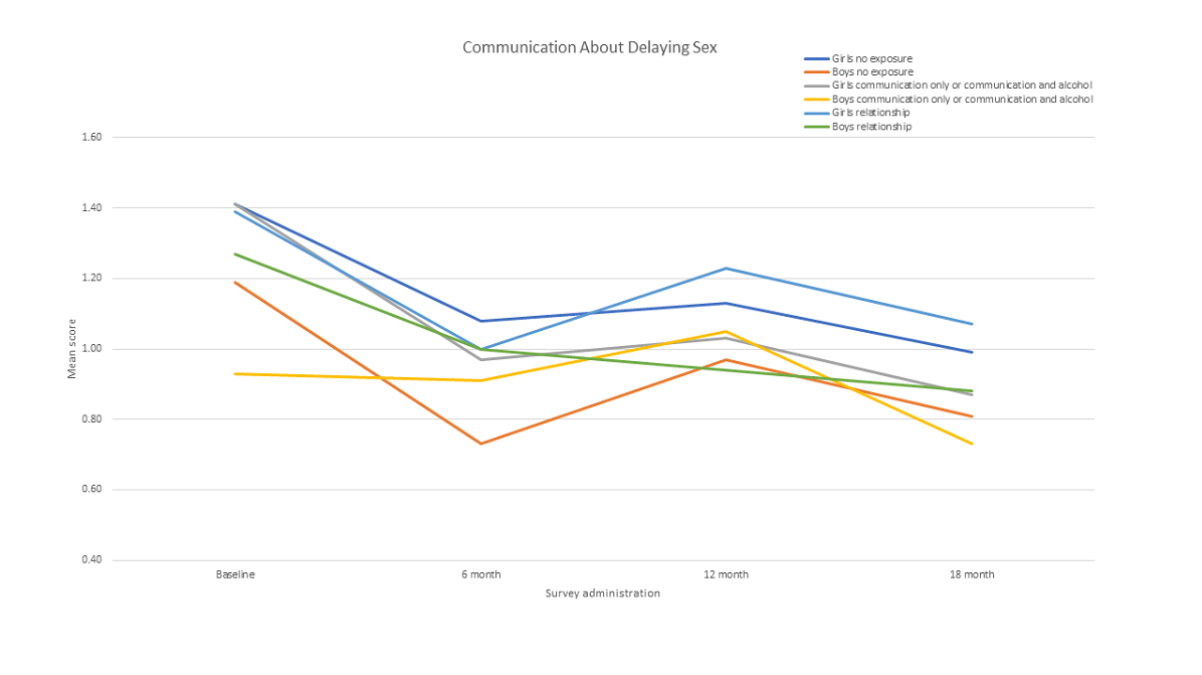
Figure 2. Gender by exposure over time (mean